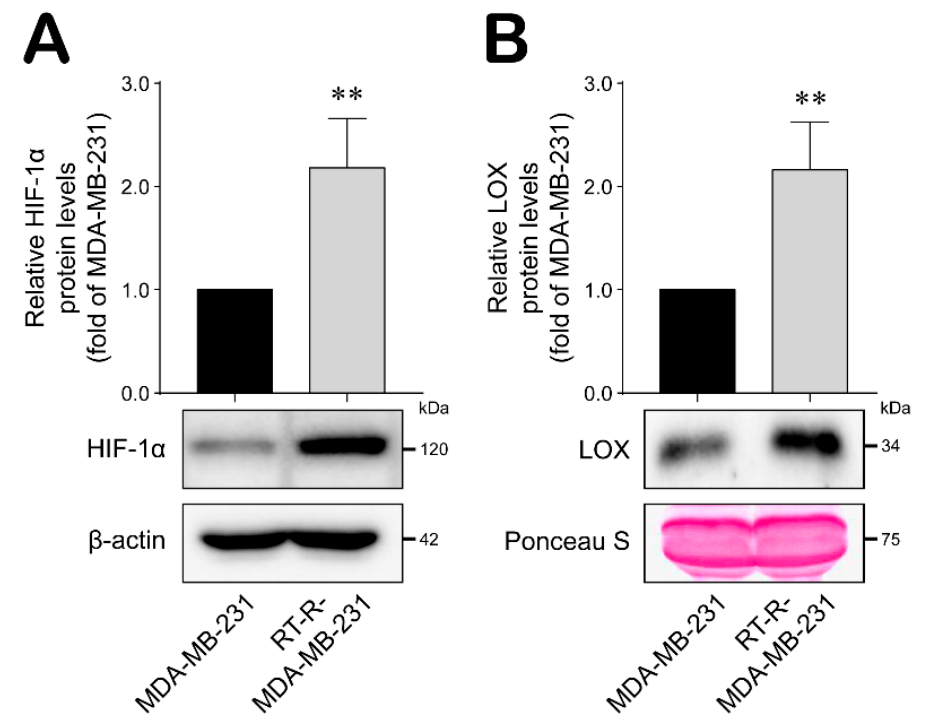
Figure 2. HIF-1 α expression and lysyl oxidase (LOX) secretion were increased in RT-R-MDA-MB-231 cells compared with MDA-MB-231 cells. ( A , B ) HIF-1 α expression level ( A ) and secreted LOX level ( B ) were detected from cell lysates and medium, respectively, by western blot analysis as described in the Methods. Data represent mean values ± standard error (SEM) of three independent experiments. Significance compared with MDA-MB-231, ** p < 0.01.